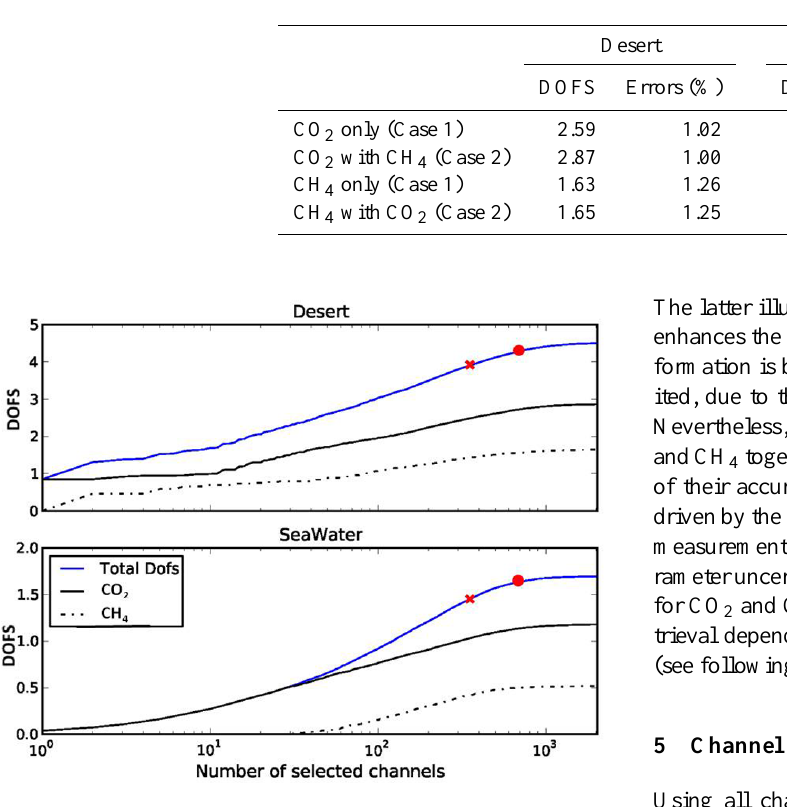
Fig. 4. Evolution of the DOFSs with number of selected channels for CO 2 (solid black line) and CH 4 (black dashed line) separately, and all together (blue line). The red crosses and circles symbolize the number of channels (355 and 694) corresponding to 75% and 90% of the total